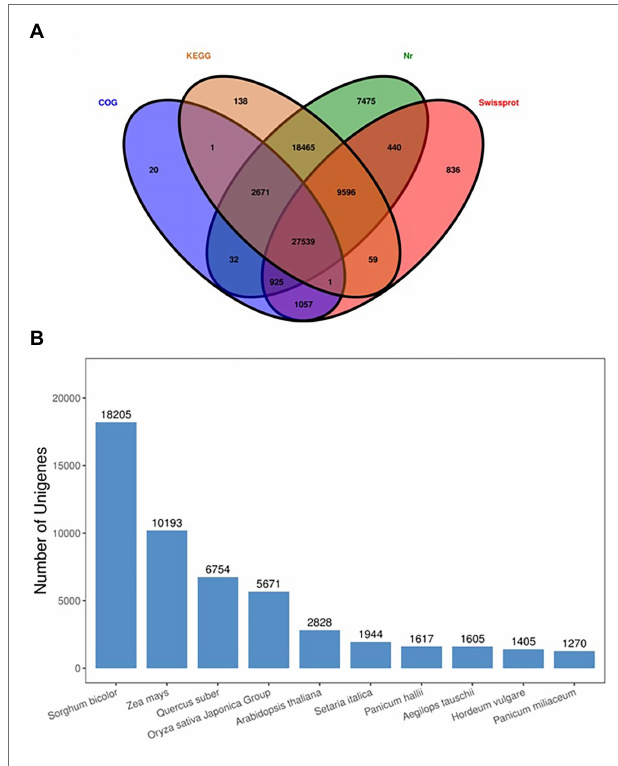
FIGURE 5 | Expression levels of each sample. The violin plot showed the gene expression (A) . The height of the curves represents density (B) . Pearson correlation analysis between all biological RNA sample (C) .